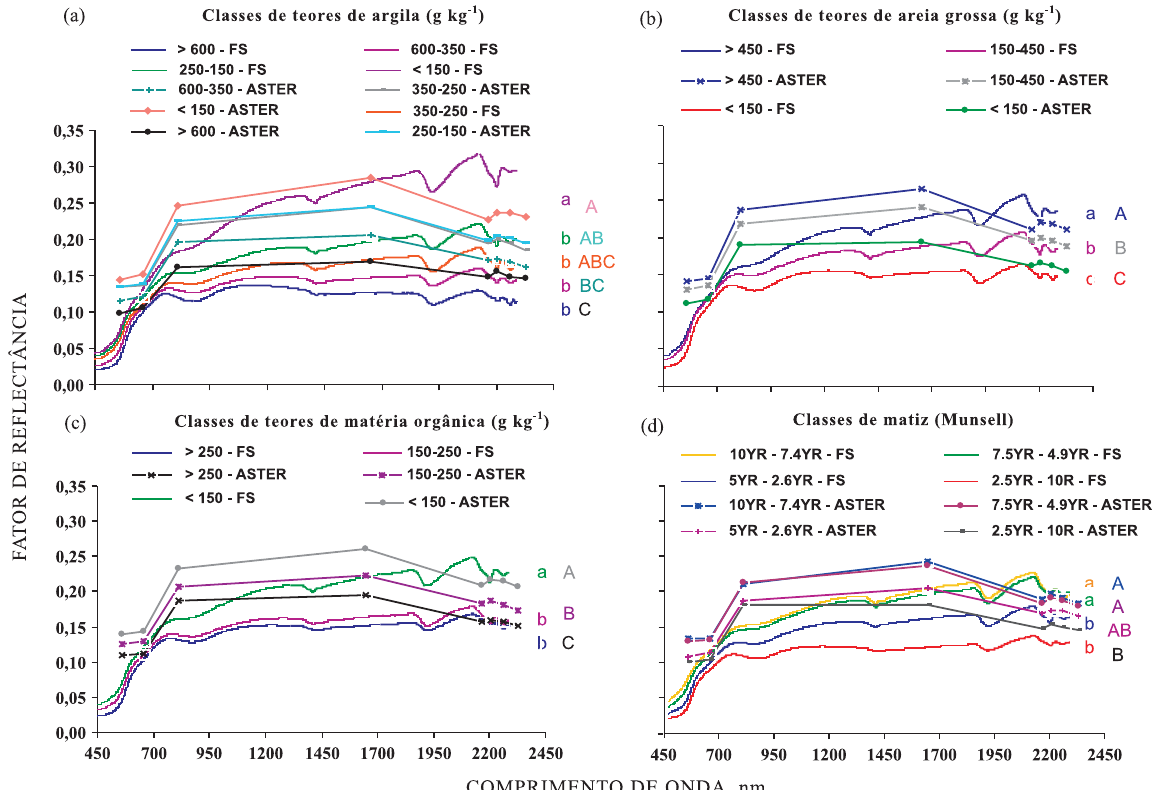
Figura 3. Variação dos atributos do solo e sua reflectância orbital (ASTER) e terrestre FieldSpec (FS). Mesma letra minúscula não difere significativamente a 5 % pelo teste de Tukey para a banda de 2.260 nm (FieldSpec). Mesma letra maiúscula não difere significativamente a 5 % pelo teste de Tukey para a banda de 2.260 nm